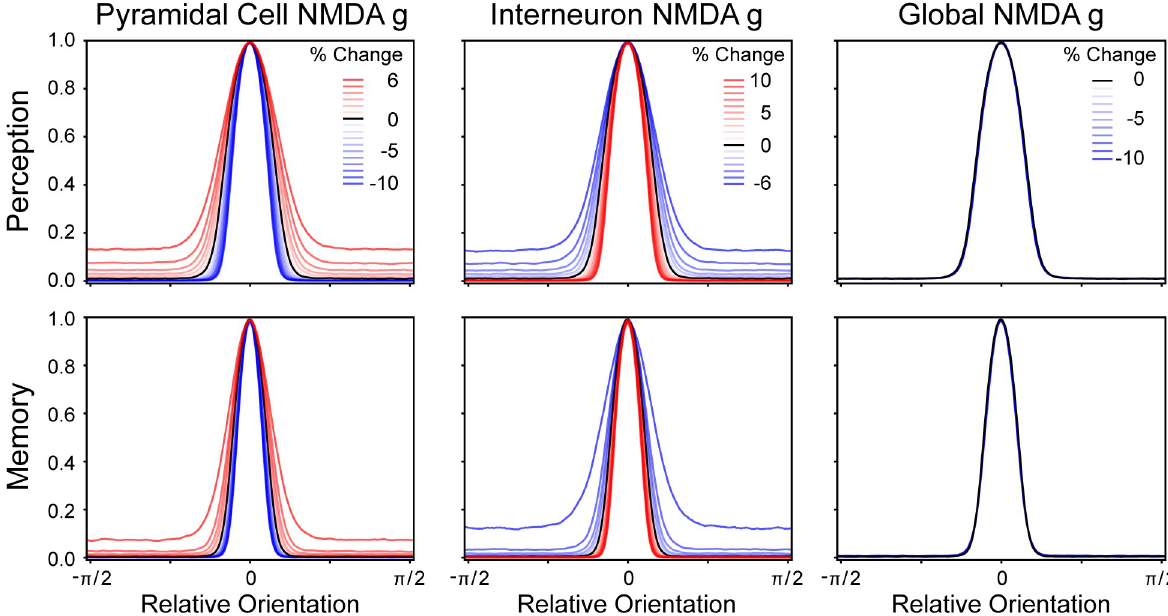
Fig 7. EI balance affects tuning curve shapes. As NMDA receptor conductance of the pyramidal cells and interneurons were systematically manipulated, it resulted in the representational tuning curves changing in width. As the NMDA conductance manipulation approached the epileptic corner of network firing (top left in Fig 3), the tuning curves became wider, and as the networks became unable to initiate or maintain a representation (bottom right in Fig 3), the tuning curves became more narrow. Notably, as the NMDA conductance parameters were globally changed (moving along the bottom left to top right diagonal in Fig 3), there was no change in the tuning curve’s shape.